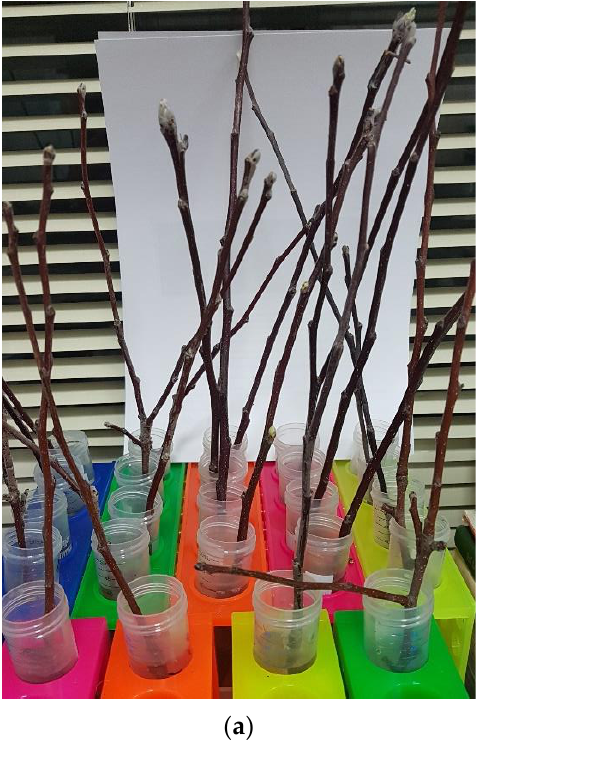
Figure 8. Release of endodormancy: ( a ) budbreak and ( b ) flowering of the apple tree shoots collected in February 2021 and grown in tap water at room temperature.